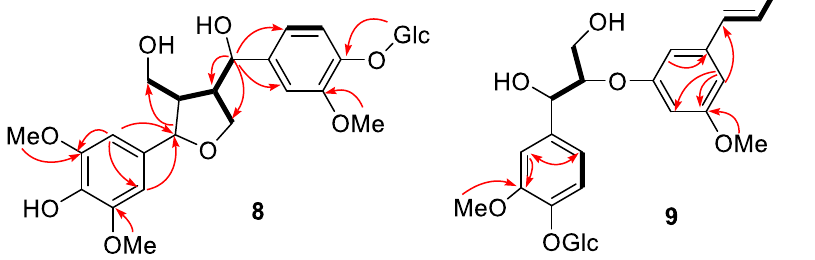
Figure 6. Selected HMBC correlations (arrows in red), COSY connectivities (bold lines) for 8 and 9 .